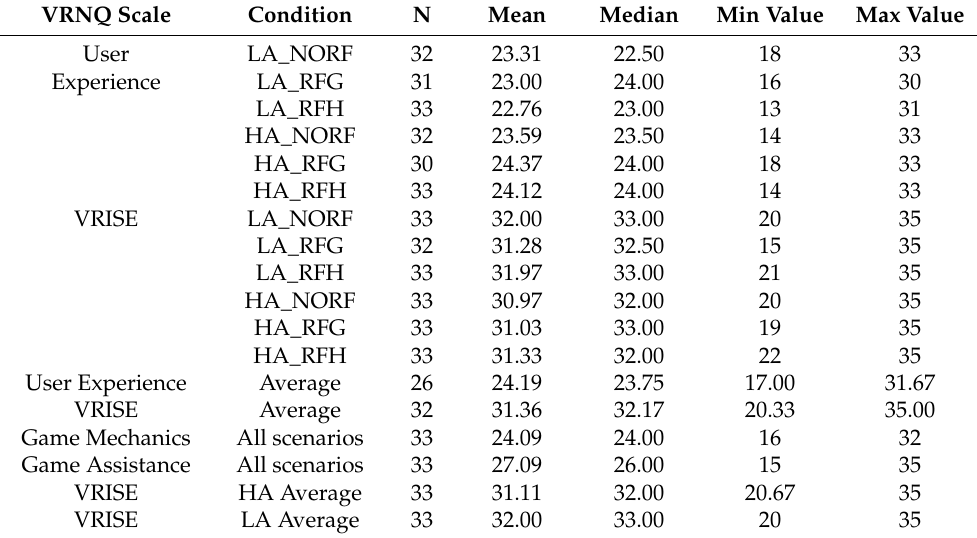
Table 21. Adequate quality of VR software assessed by VRNQ Questionnaire. The results are presented by game conditions for user experience and VRISE subscales of VRNQ Questionnaire, and also for average scores across all six conditions. As the Game Mechanics and Game Assistance part of the VRNQ Questionnaire were fulfilled only at the end of the experiment, the results are not presented by game conditions. The results for the VRISE subscale of the VRNQ Questionnaire are also given for average scores across high activity and low activity modes of the game. Since cut-offs for assessing the adequate quality of VR software are based on the values of the medians, the medians are included in the descriptive